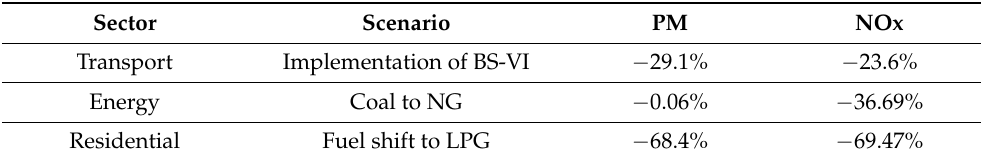
Table 1. Proposed emission scenarios for the different sectors for PM and NOx emissions (Source: NEERI, 2008). Sector Scenario PM NOx Transport Implementation of BS-VI − 29.1% − 23.6% Energy Coal to NG − 0.06% − 36.69% Residential Fuel shift to LPG − 68.4% −